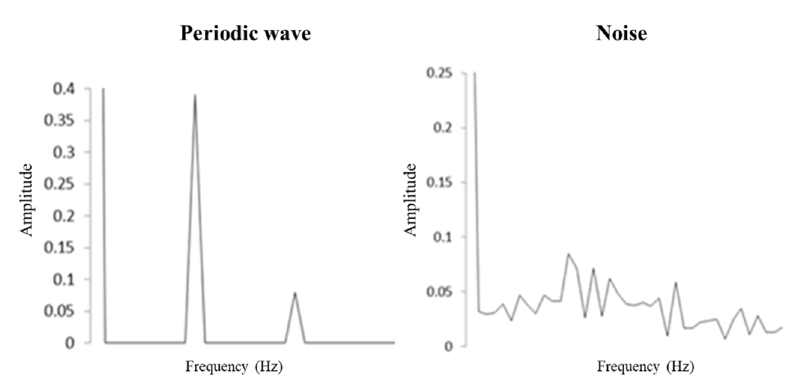
Figure 5. Visual illustration of Fast Fourier Transform analysis.